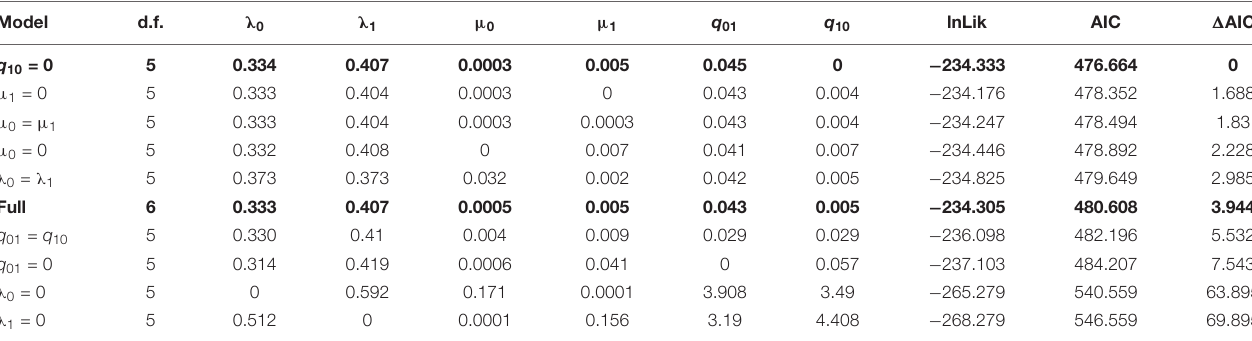
TABLE 3 | The fit of BiSSE models of photosynthetic pathway evolution in the Cirrhopetalum alliance based on Dataset 3.